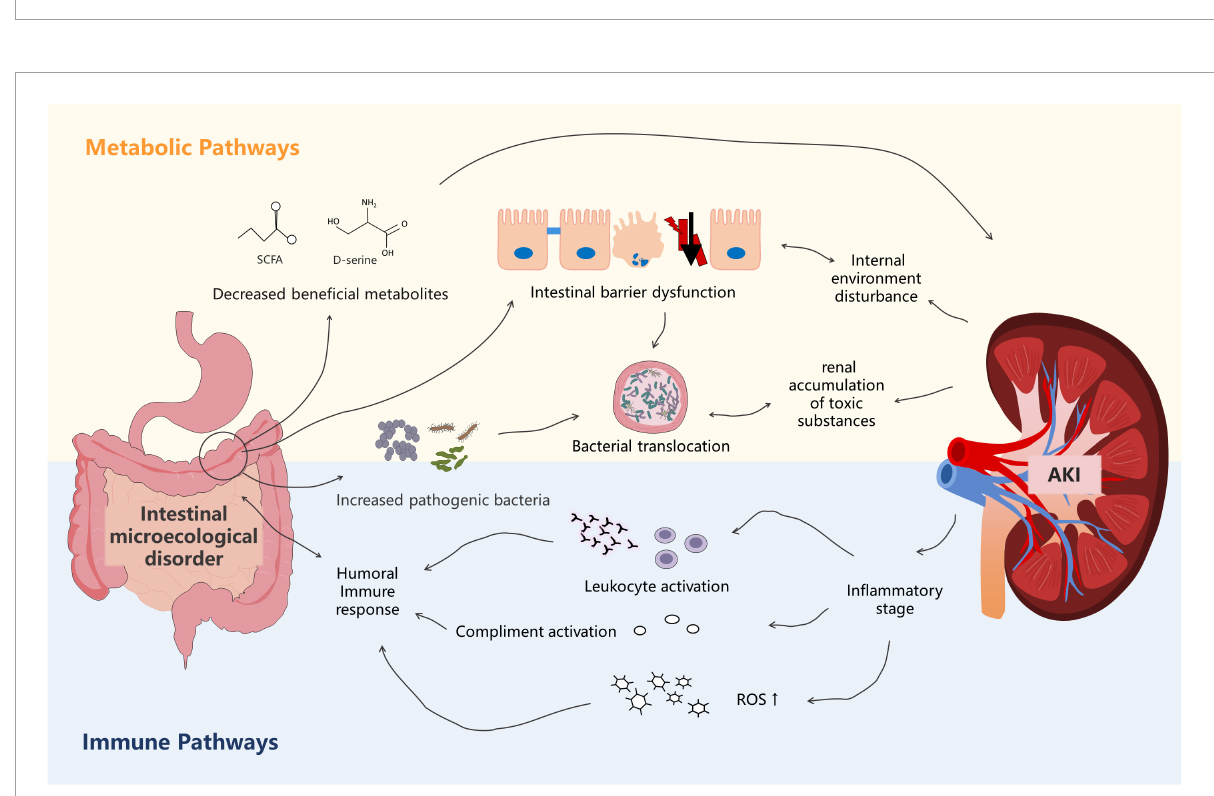
FIGURE2 The metabolism-dependent and immune pathways of the gut–kidney axis in sepsis. Dysbiosis of the gut microbiota is associated with altered metabolic pathways that cause accumulation of uremic toxins, leading to kidney injury. Kidney injury, in turn, affects the gut microecology. In the immune pathway, products derived from bacterial members of the gut microbiota evoke immune signaling pathways in the host, leading to systemic inflammatory syndrome. Kidney injury also affects